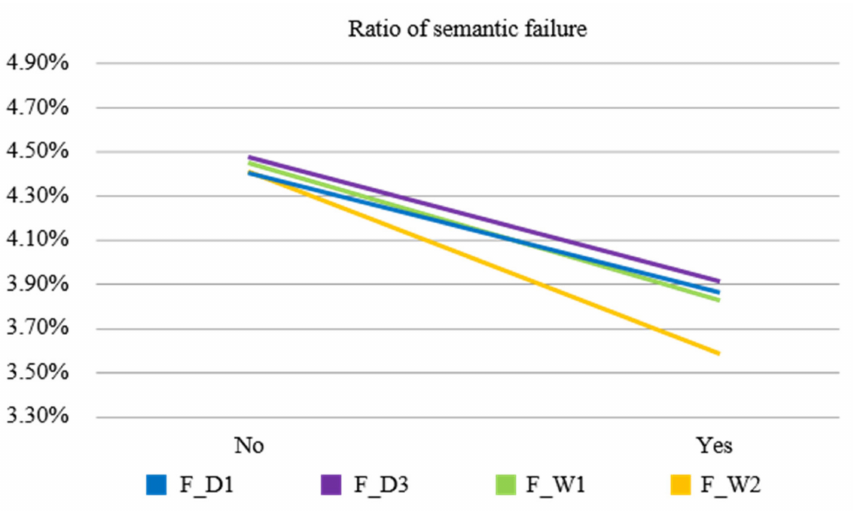
Figure 8. Ratio of semantic